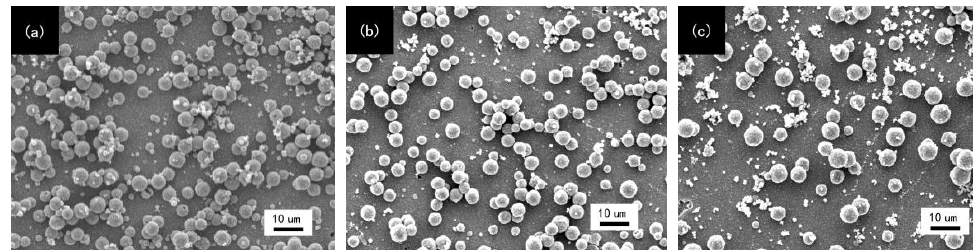
Figure 3. SEM images of copper film after saline solution immersion. ( a ) TES-SAMs modified; ( b ) MPTMS-SAMs modified; ( c ) APTES-SAMs